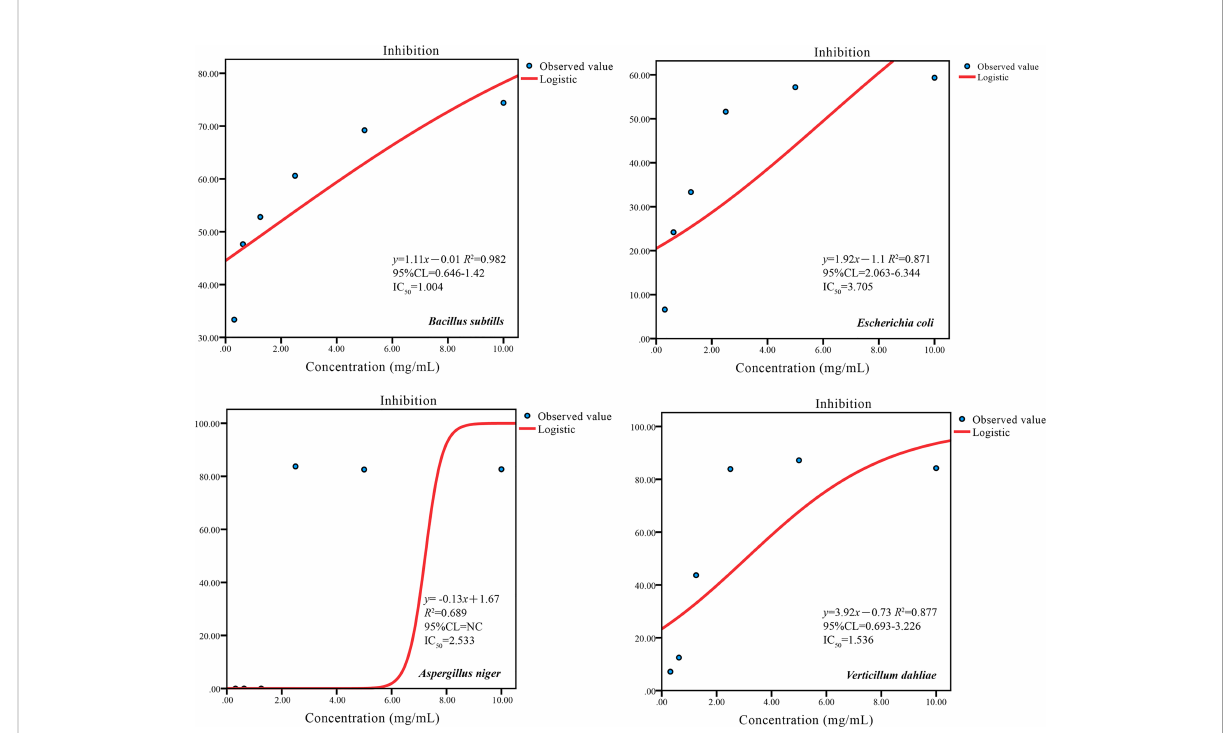
FIGURE 6 Dose – response curves of A. tibetica EO against tested microorganisms. R 2 adj: adjusted coef fi cient of determination. IC 50 : 50% inhibit concentration of microorganisms. 95% CL: 95% con fi dence limits; NC, not